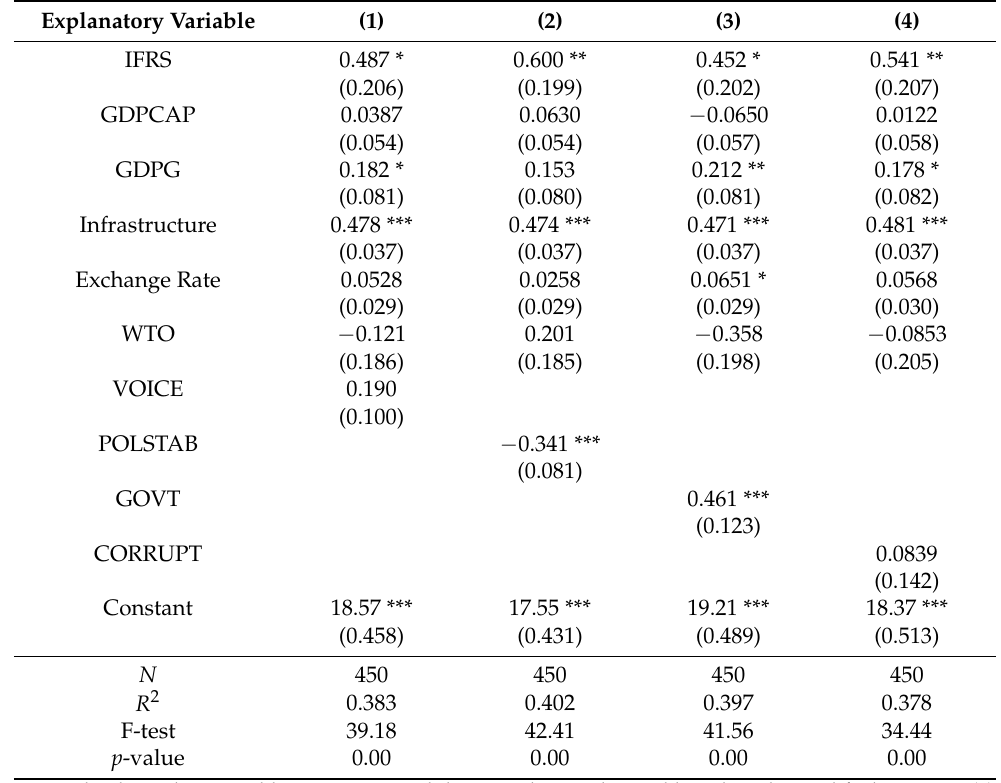
Table 2. Benchmark OLS estimation results without individual time effects. Explanatory